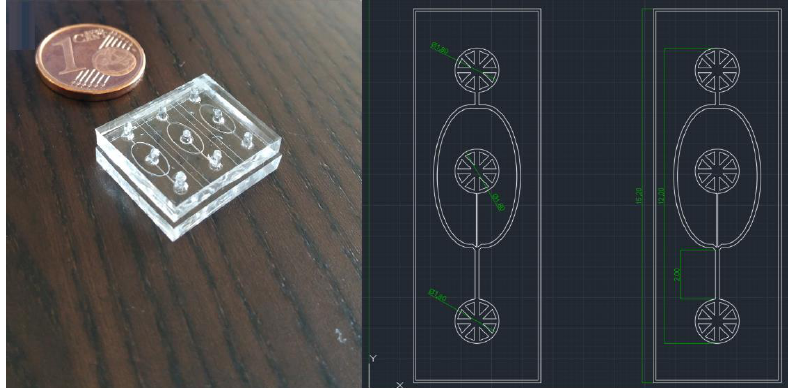
Figure 2. ( left ) Image of the polydimethylsiloxane (PDMS) microfluidic device structure once aligned and bounded. There are a total of three coaxial systems in a single piece of PDMS, which is similar to the size of a one cent coin. ( right ) AutoCAD design of the microfluidic system with representative dimensions shown in mm. The region where the coaxial inner flow is formed has 2 mm of length.